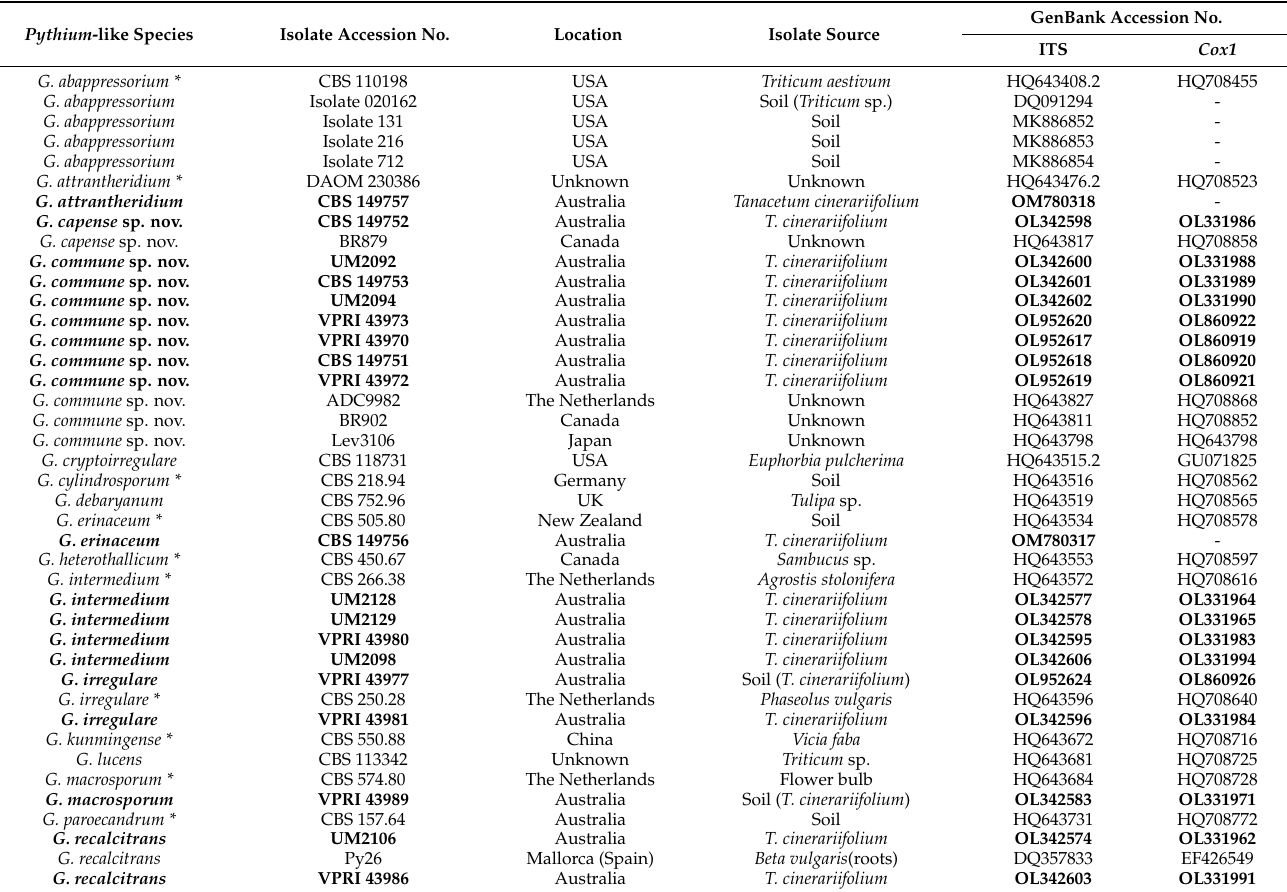
Table 4. Information about the Pythium and Globisporangium spp. isolates used in this study. Pythium -like Species Isolate Accession